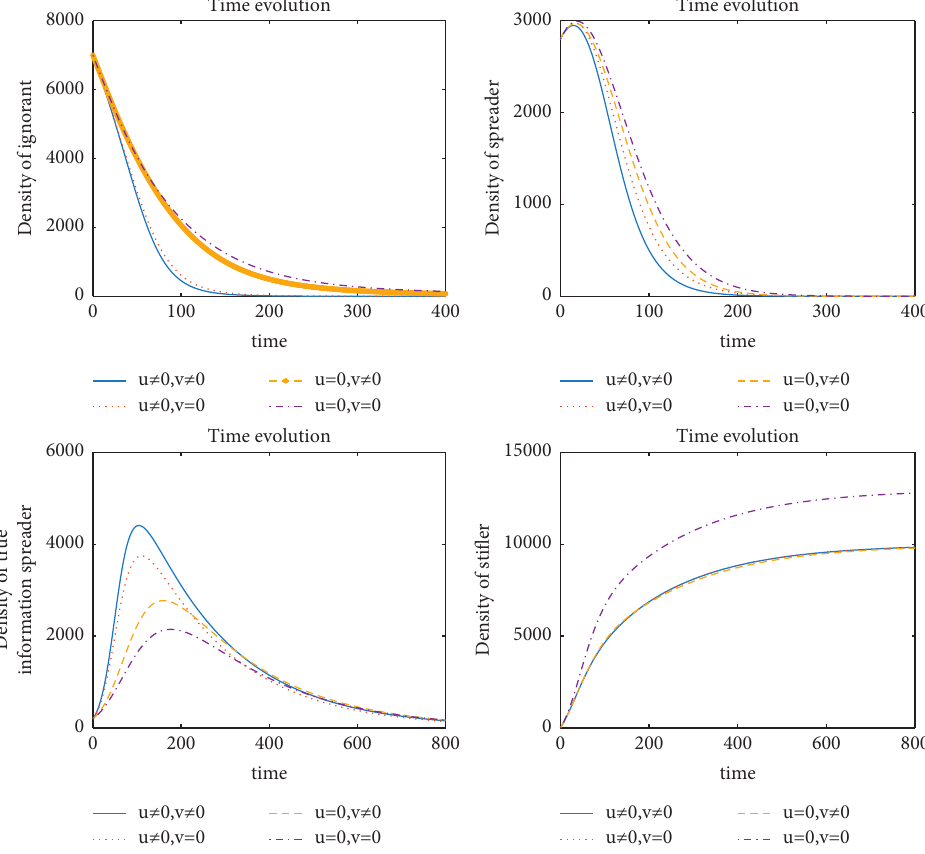
Figure 5: Time evolution of density of different group with control or without control.